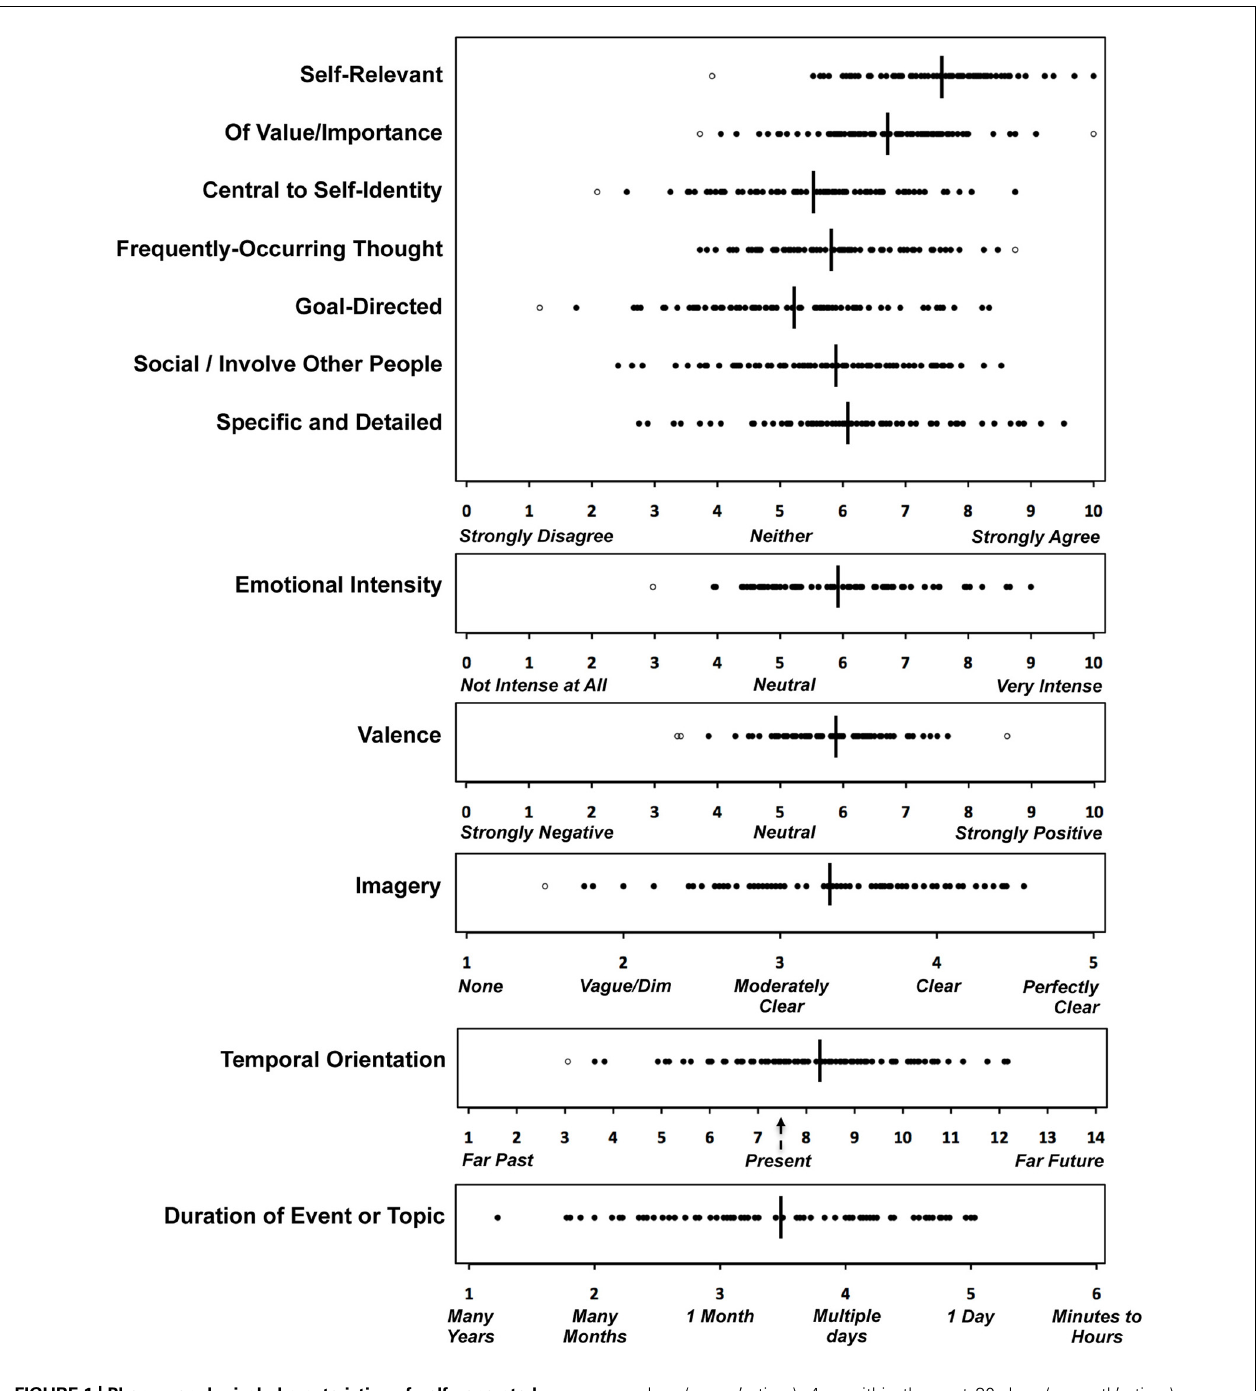
days (a year’s time), 4 = within the past 30 days (a month’s time), 5 = within the past 7 days (a week’s time), 6 = yesterday, 7 = earlier today, 8 = later today, 9 = tomorrow, 10 = within the next 7 days (a week’s time), 11 = within the next 30 days (a month’s time), 12 = within the next 365 days (a year’s time), 13 = within the next 3 years, 14 = more than 3 years from